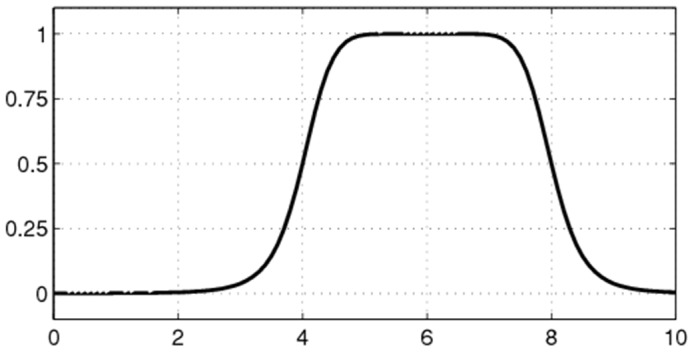
Bell-shaped membership function (a = 2, b = 4, c = 6).